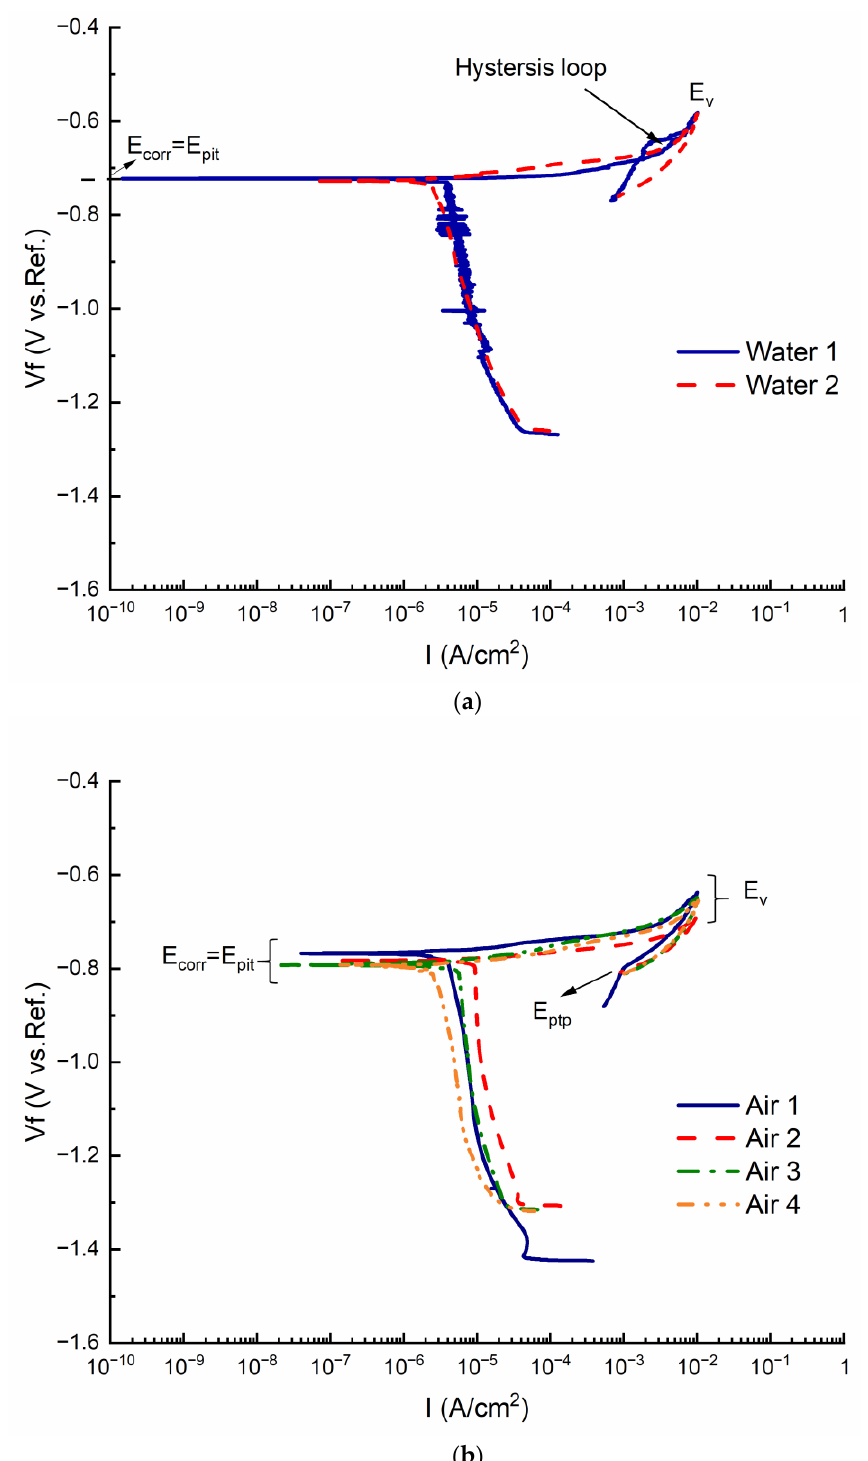
Figure 10. Cyclic polarization scans for ( a ) water-quenched part, and ( b ) air-cooled part of the Quenched AA7075-T6 in 3.5% NaCl.